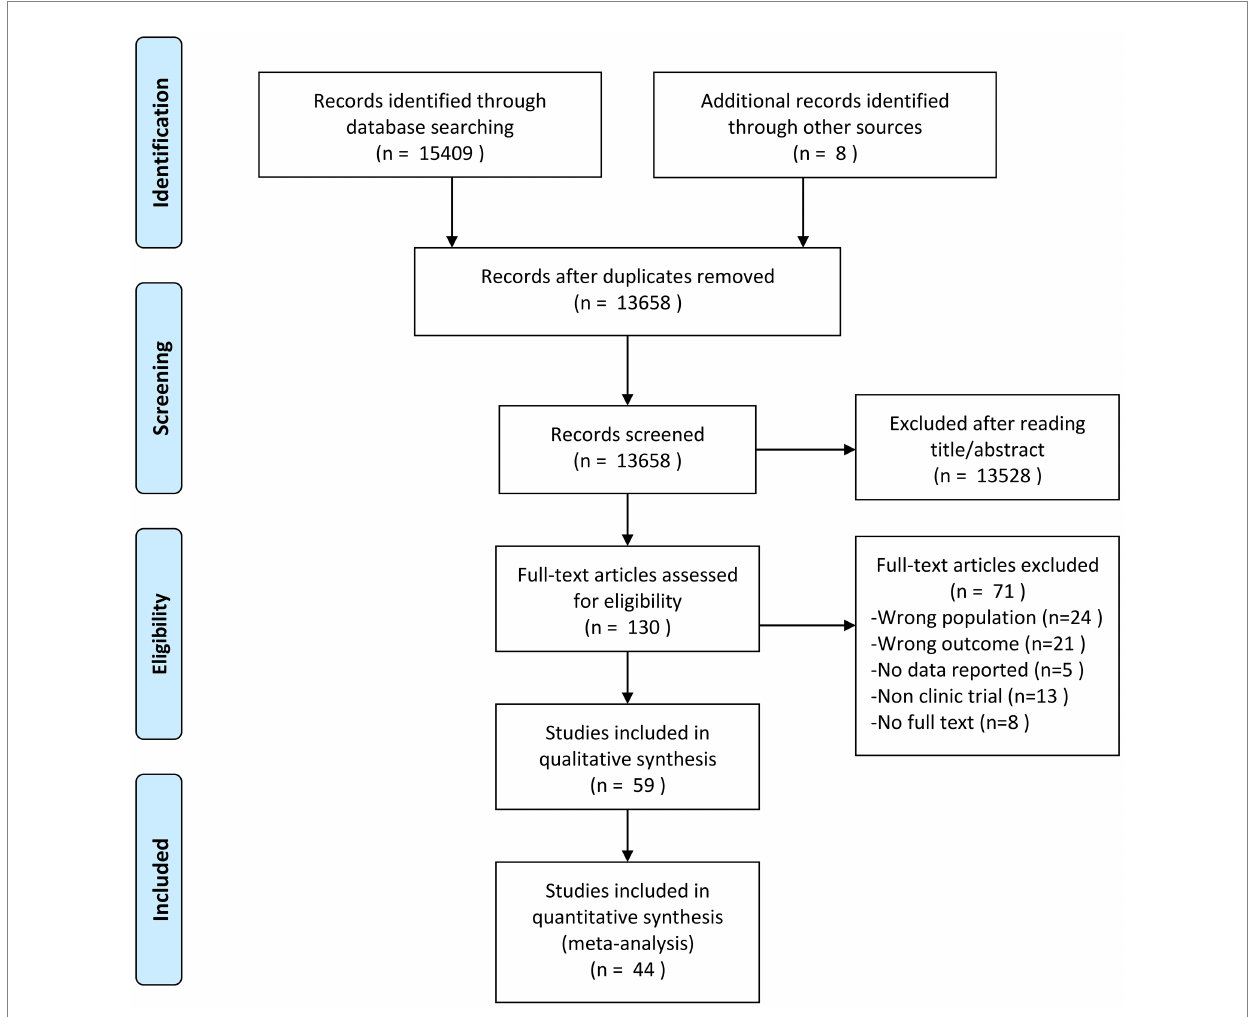
FIGURE 1 PRISMA flow diagram of the search process for